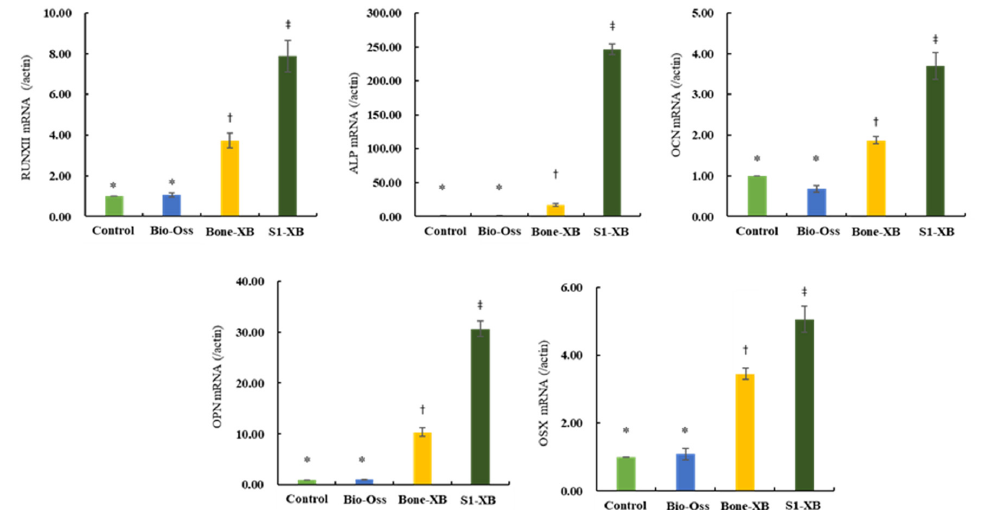
Figure 6. The effects of the three bone substitute extracts on osteogenesis-related genes. hMSCs were cultured in osteogenic induction media supplemented with 50% extracts for 12 days. The mRNA expressions of osteogenic differentiation-related genes, that is, Runx2, OSX, ALP, OCN, and OPN were determined by qPCR. Normalization was performed versus β -actin expression. “*”, “†”, “‡” Different letters indicate significant differences ( p < 0.05).